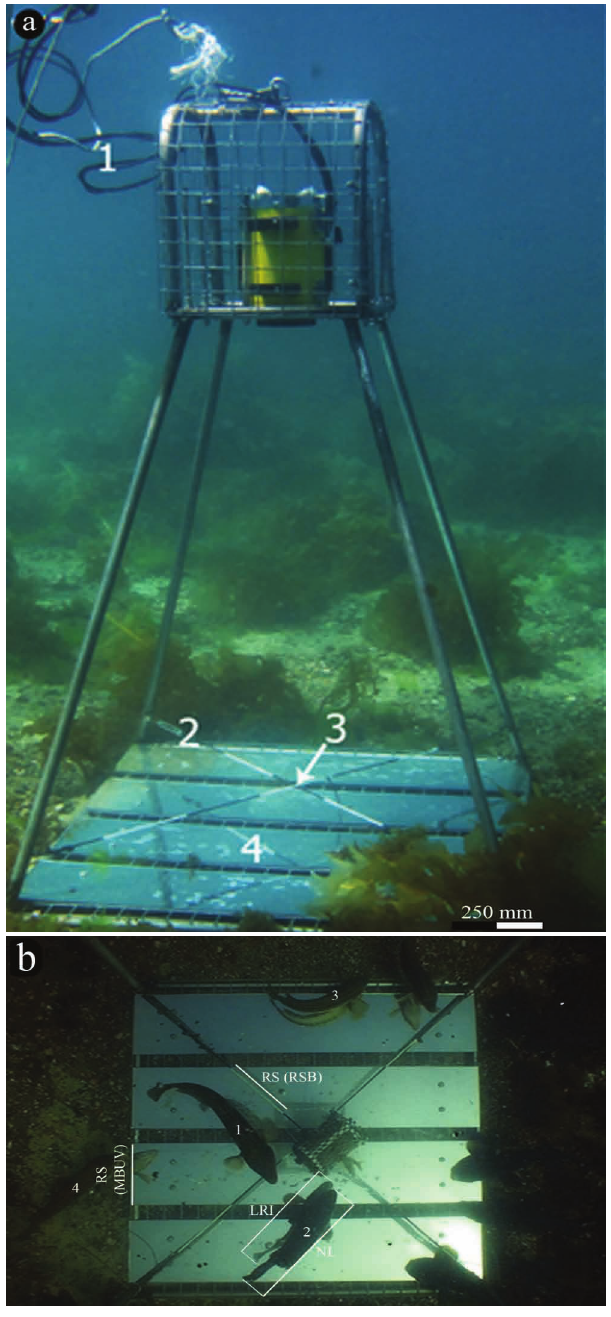
Fig. 1. Mirrored baited underwater video system (MBUV). (a) MBUV settled on bottom for calibration purposes: 1) video signal and remote control, 2) strained cables marked every 200 mm segments, 3) placement of the bait holder, 4) mirrored surface; (b) Camera view of a MBUV deployment showing the naive length of a sea bass Acanthistius patachonicus (NL), the length of its reflected image (LRI), and the reference scales (RS = 200 mm) used for applying the MBUV and Reference scale at the bait level (RSB) procedures. Four fishes (1-4) could be accurately measured in this snapshot; fish #4 could be sized even when its body laid wholly outside of the mirrored area but was partially reflected by